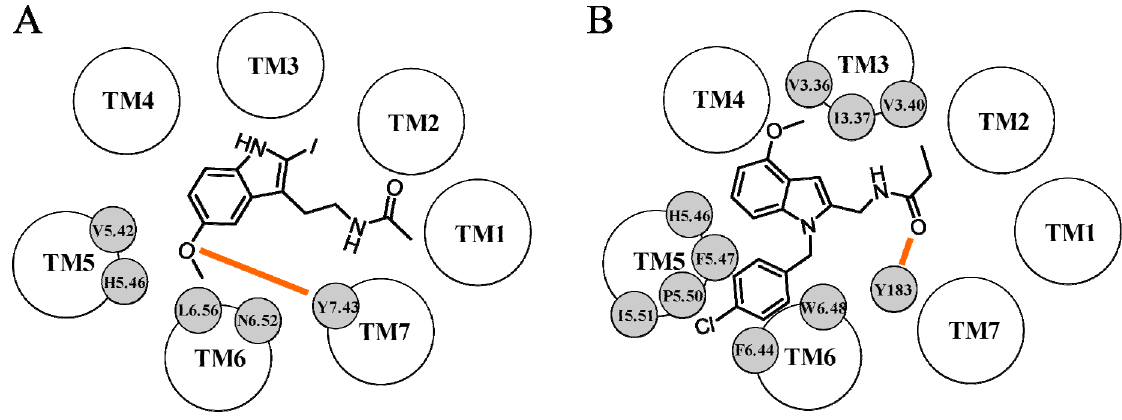
Figure 7. Representation of the binding scheme of 2-iodomelatonin proposed by Mazna et al. ( A ) and of UCM454 proposed by Rivara et al. ( B ) within the MT site. Hydrogen bond interactions are depicted with orange